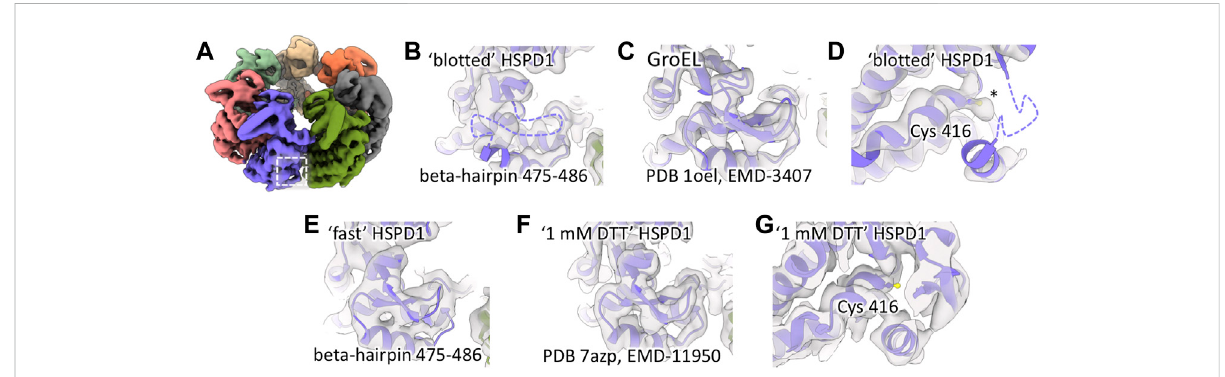
FIGURE 1 LocalunfoldingandadditionaldensityforCys416ofHSPD1. (A) Reconstructionof “ blotted ” HSPD1(determinedto3.4Å) withtheregionaround beta-hairpin 475 – 486 highlighted by the box. (B) Beta-hairpin 475 – 486 is unfolded in “ blotted ” HSPD1, the unresolved region is indicated with a dashed purple line. (C) Equivalent region in GroEL (determined to 3.3Å), showing an intact beta-hairpin. (D) Additional density for Cys416 in “ blotted ” HSPD1, indicated by an asterisk. (E) “ Fast ” HSPD1 (determined to 6.8Å) has density indicating an intact beta-hairpin 475 – 486. (F) “ 1 mM DTT ” HSPD1 (determined to 3.5Å) shows an intact beta-hairpin 475 – 486 and (G) no additional density for